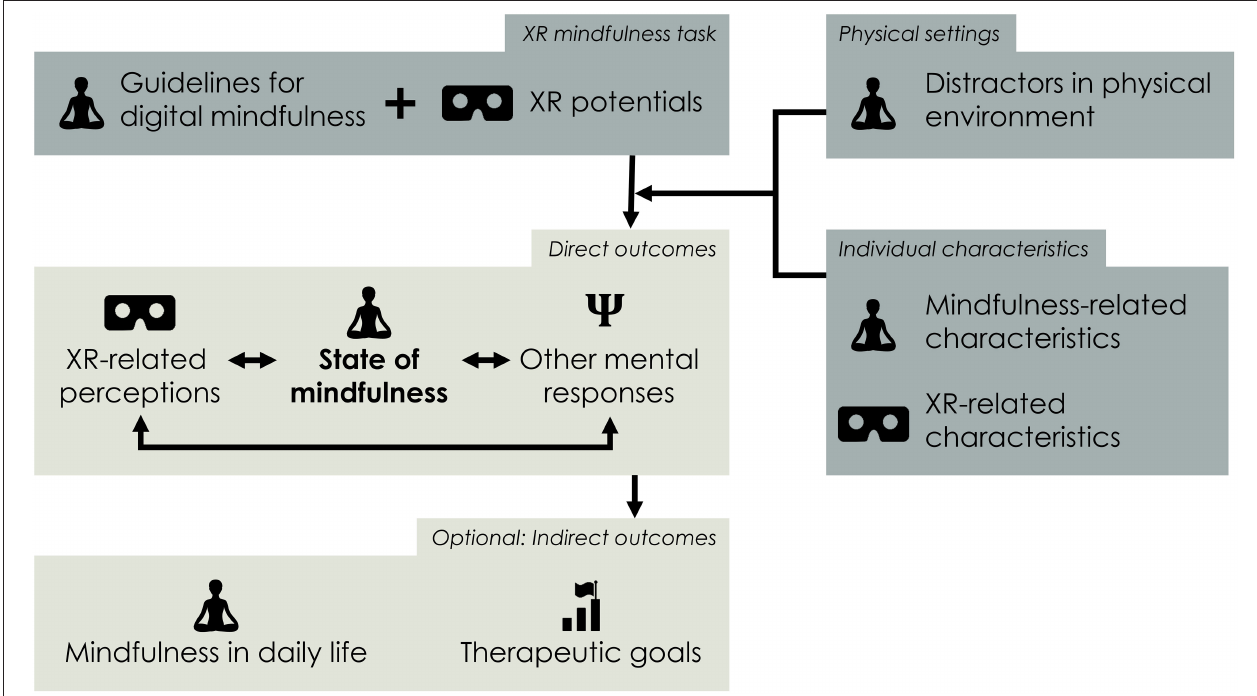
FIGURE 5 | Framework of the influence of XR elements on mindfulness and mindfulness-related concepts. The darker boxes include variables that impact or moderate the outcomes of our interactions. The lighter boxes represent the outcomes, divided into direct responses to the XR experience and indirect target outcomes.